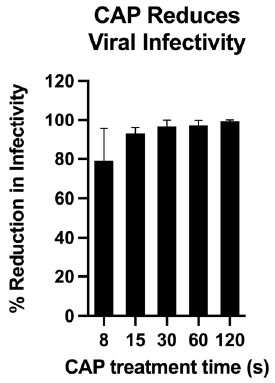
Figure 6. % Reduction in infectivity vs. CAP treatment